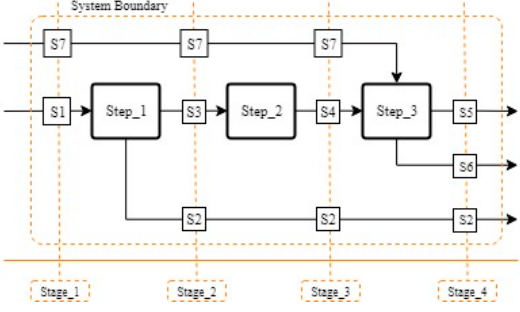
Figure 7. Stage-node diagram of a three-step system with two inputs and three outputs.